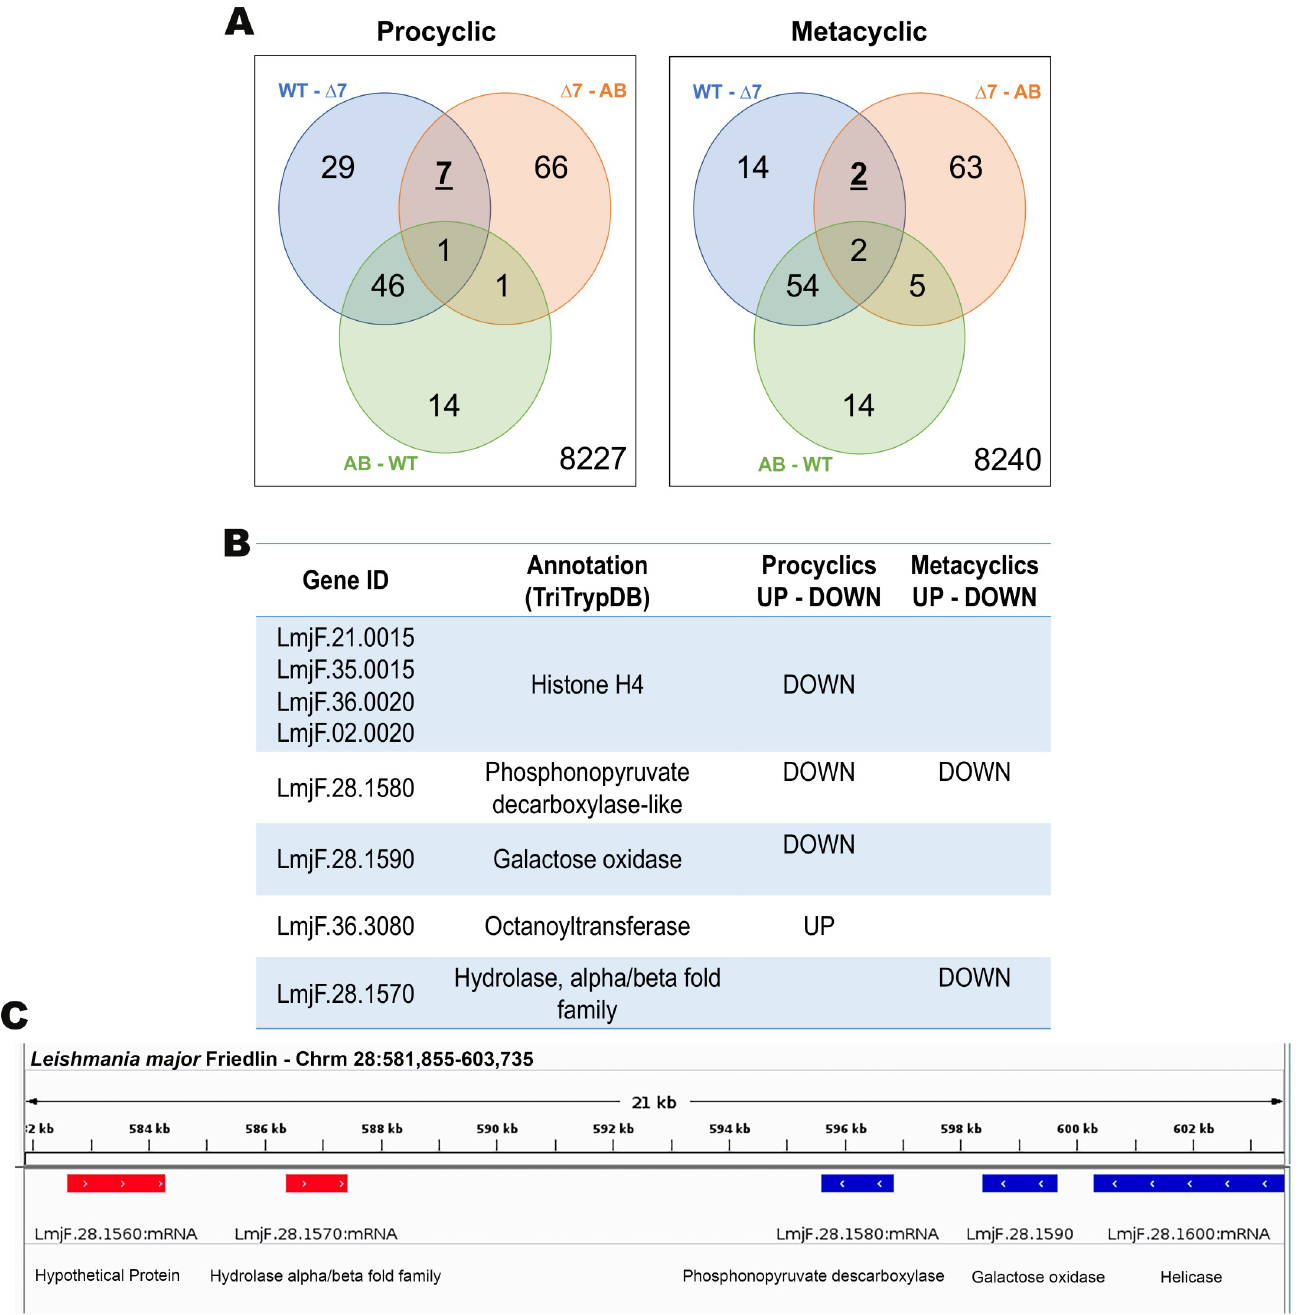
Fig 7. Analysis of transcripts differentially expressed in the LmjPRMT7 compared transfectants. (A) Venn diagram of the three contrasts obtained after differentially expressed analysis of transcriptomes from L . major parasite samples (WT, Δ lmjPRMT7 and Δ lmjPRMT7 [PRMT7]). In bold the DEG only differentially expressed in Δ 7 compared to WT and AB but not between the last two groups (FDR 5%, FC > 1.5). On the right bottom corner, the number of genes with no expression difference found between the groups. (B) Description of genes showed in bold in the Venn Diagram. (C) The convergent switch strand region on chromosome 28 depicting the location of three of the DEG identified, LmjF.28.1580, LmjF.28.1590 and LmjF.28.1570.